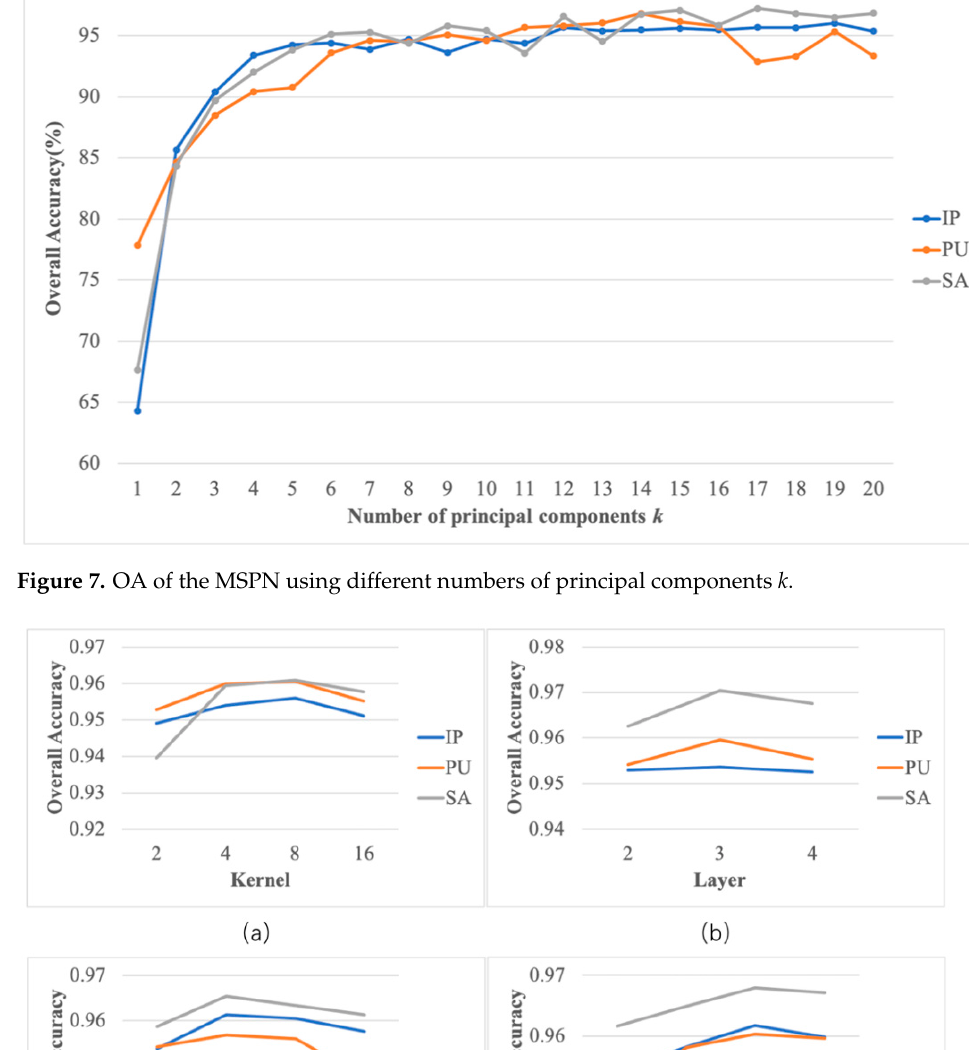
Figure 7. OA of the MSPN using different numbers of principal components k .